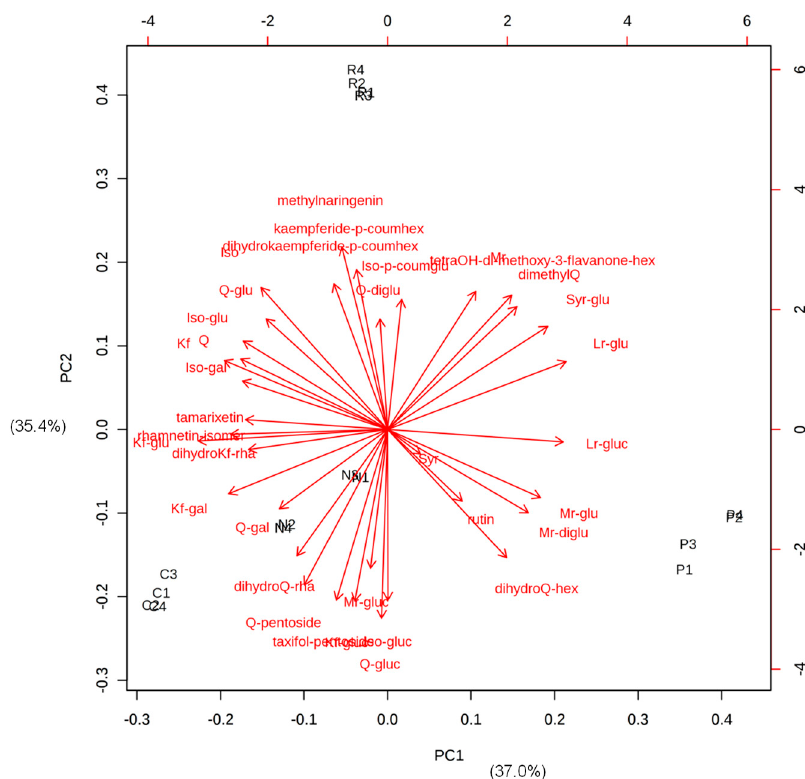
Figure 2. Biplot of the normalized UHPLC-Q/TOF signal intensities of non-anthocyanic flavonoids identified in the four grape varieties. P: Primitivo, C: Corvina, N: Negro Amaro, R: Raboso Piave. Mr, myricetin; Iso, isorhamnetin; Q, quercetin; Syr, syringetin; Lr, laricitrin; Kf, kaempferol; glu, glucoside; diglu, diglucoside; gluc, glucuronide; hex, hexoside; gal, galactoside; rha, rhamnoside; p-coumhex, p -coumaroylhexoside.